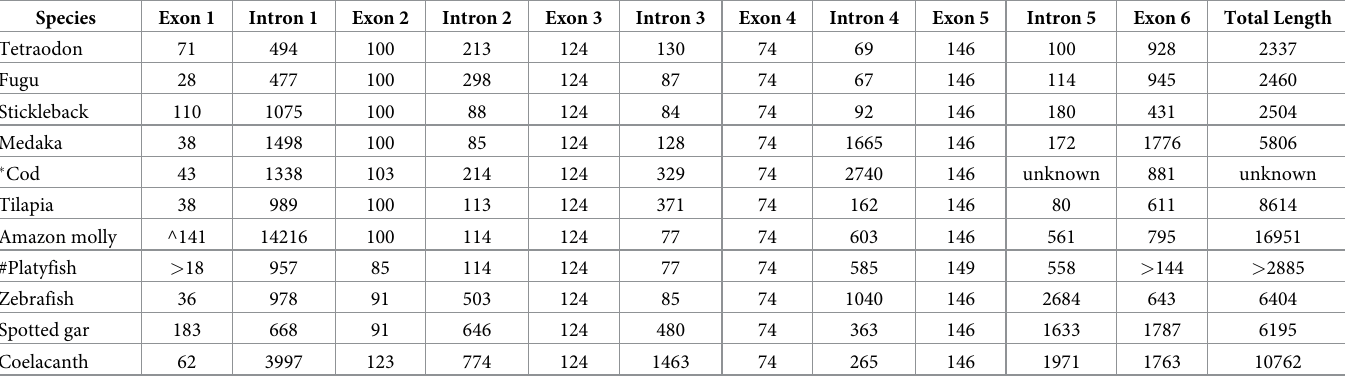
Table 6. Characterization of fish Zmat2 genes (in base pairs).